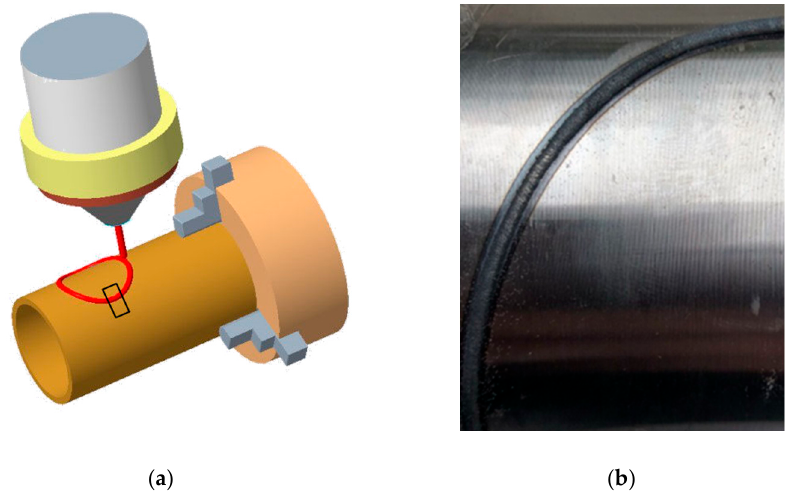
Figure 3. ( a ) Schematic cladding path. ( b ) Sample clad on a curved surface. Table 3. Experimental design and results.